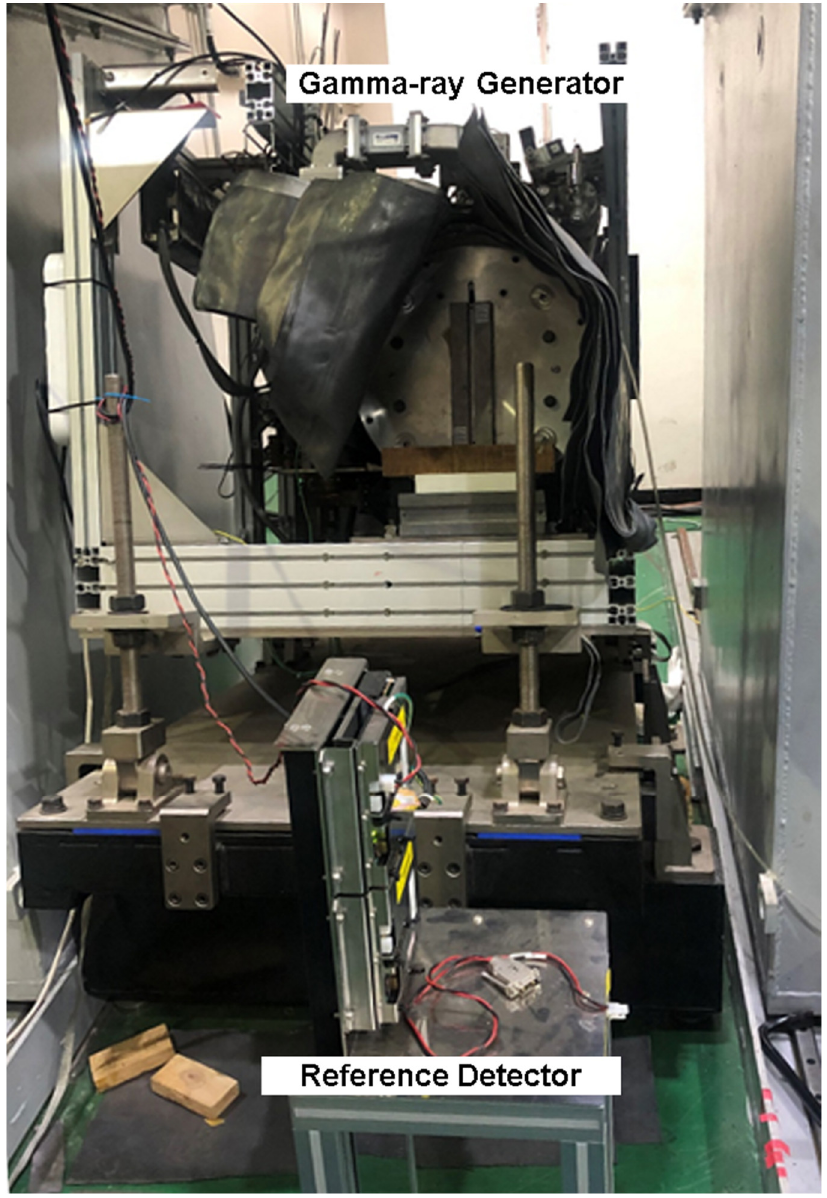
Figure 2. Gamma-ray generator. The gamma-ray beam is produced from the linear accelerator (LINAC) in the tungsten target by the bremsstrahlung interaction. In front of the LINAC, the reference detector is installed.